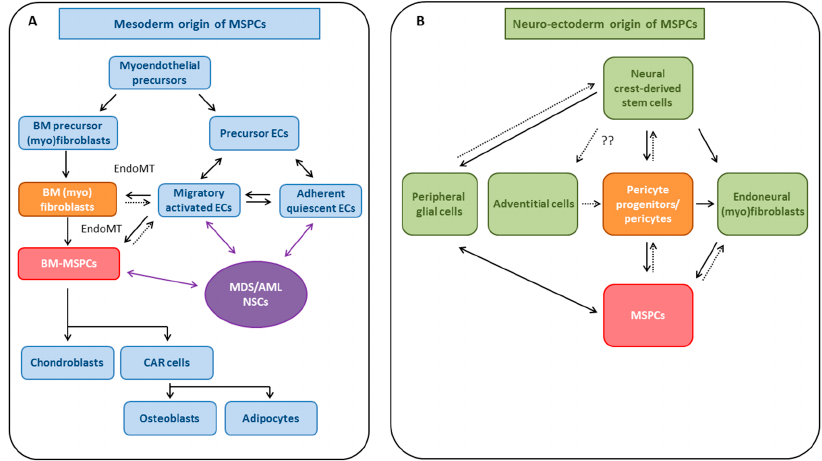
Figure 1. Presumed ontogenetic origin of mesenchymal stem and progenitor cells (MSPCs). MSPCs are a heterogeneous mixture of subpopulations, which may derive from differing developmental origins. ( A ) Model for mesoderm origin of MSPCs. Blood vessel-derived myoendothelial precursor cells may give rise to bone marrow (BM) precursor myofibroblasts as well as precursor (proto) endothelial cells (ECs), which can shift between a quiescent endothelial and a proliferative migratory phenotype. The latter may (trans)differentiate into BM-MSPCs via endothelial-to-mesenchymal transition (EndoMT) either directly, or indirectly via BM (myo)fibroblasts. MSPCs also stabilize and deliver pro-survival and maturation signals to ECs. MSPCs give rise to three mesodermal lineages in vitro, namely chondroblasts, osteoblasts, and adipocytes. The latter two derive from CXCL12 + abundant reticular (CAR) cells with bi-lineage (adipo-osteogenic) potential. Myelodysplastic syndromes/acute myeloid leukemia neoplastic stem cells (NSCs) interact with and modulate MPSCs, as well as both migratory-activated and adherent quiescent ECs; ( B ) Model for neuro-ectoderm origin of MSPCs. Neural crest-derived stem cells (NCSCs) are thought to give rise to (i) peripheral glial cells (a process which may be reversible as indicated by dotted arrows); (ii) endoneural (myo)fibroblasts either directly or indirectly via development from (iii) pericyte progenitors/pericytes (in the brain and the central nervous system), all of which can give rise to MSPCs (a process which may be reversible as indicated by dotted arrows). Possibly pericytes may also develop from adventitial cells. Solid